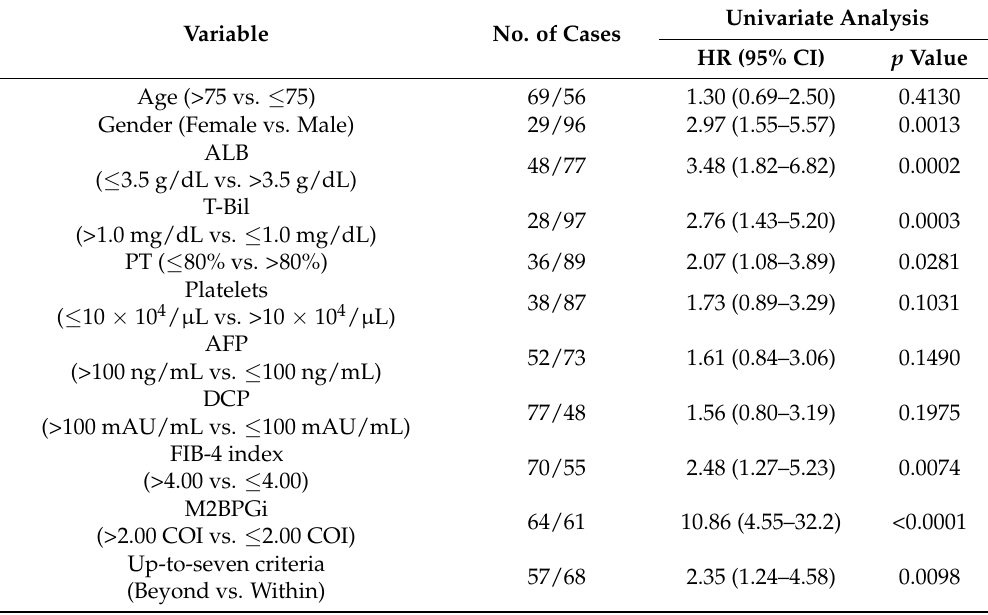
Table 2. Univariate analysis of the factors associated with Child-Pugh grade deterioration from A to B among patients who underwent transarterial chemoembolization.